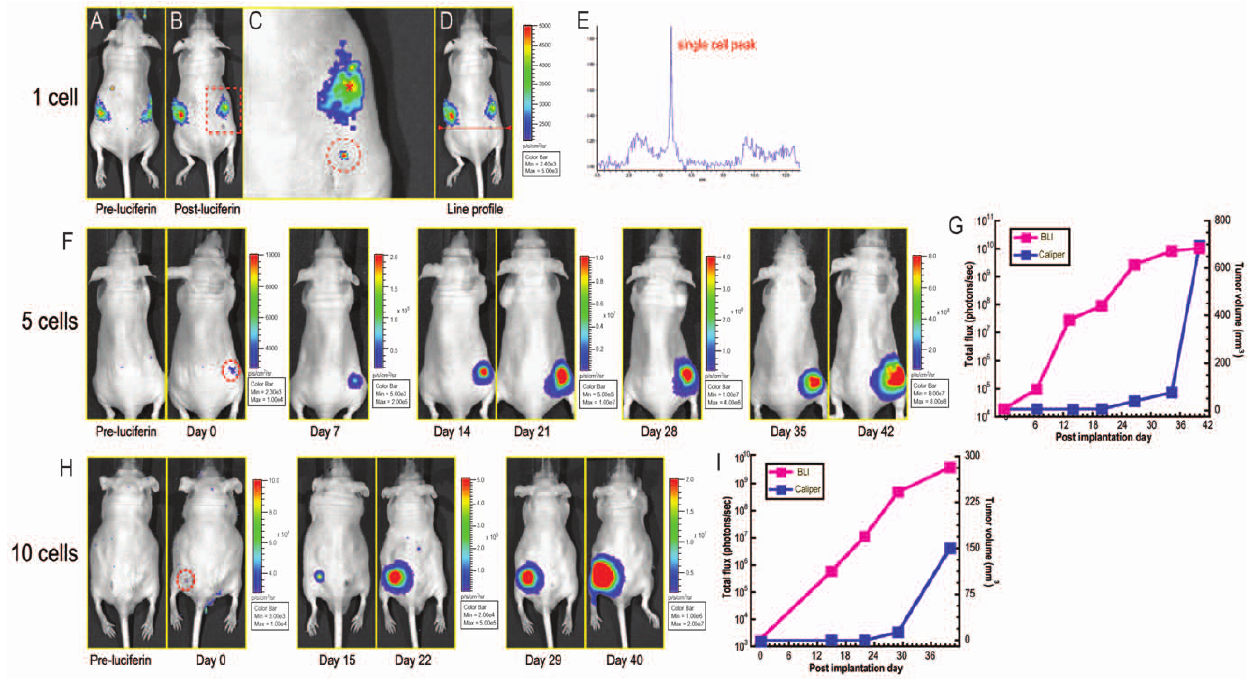
Figure 3. Detection of a single 4T1-luc2-1A4 cell invivo . (A-C) Bioluminescent signal of a single 4T1-luc2-1A4 cell in vivo . A single cell was implanted into the back of a nu/nu mouse. D-luciferin was injected into the mouse intraperitoneally and bioluminescent images were taken using an IVIS Spectrum (FOV; C, binning; small, f stop; 1, exposure time; 5 min). Images for pre- and post-luciferin injection were shown in panels (A) and (B), respectively. Magnified image of the dotted area from panel (B) is shown on panel (C). The dotted circle represents the single cell signal. The asterisk (*) indicates the background signal from the gut. (D,E) Line profiling analysis of single cell signal. Light emission was plotted along the line shown on panel (D). Peak signal in the panel (E) represents the light emission from a single 4T1-luc2-1A4 cell. (F) Tumor development from five 4T1-luc2-1A4 cells. Cells were implanted subcutaneously (using a micropipette) into the dorsal flank region of a nu/nu mouse. Bioluminescent images were first taken before the D-luciferin injection (Pre-luciferin). The animal was then imaged on day 0 through day 42. (G) Monitoring of tumor growth from 5 cells of 4T1-luc2-1A4. Bioluminescent signals were quantified using Living Image software and plotted against physical tumor volume measurements by a caliper. Tumor was not palpable till day 27 post-implantation while bioluminescent signals were detected from the day 0. Note that total flux was plotted in a logarithmic scale. (H) Tumor development from 10 cells of 4T1-luc2-1A4. Cells were implanted subcutaneously (using a micropipette) into the back of a nu/nu mouse. The background signal is shown in pre-D-luciferin injection image (Pre-luciferin). The tumor growth was monitored for 40 days using an IVIS Spectrum and a caliper. (I) Monitoring of tumor growth from 10 cells of 4T1-luc2-1A4. Tumor volumes were measured using a caliper and plotted against bioluminescent signals which were quantified using Living Image software. Tumor was not palpable till day 29 after implantation. On the contrary, bioluminescent signals were distinct from the day 0 of implantation.